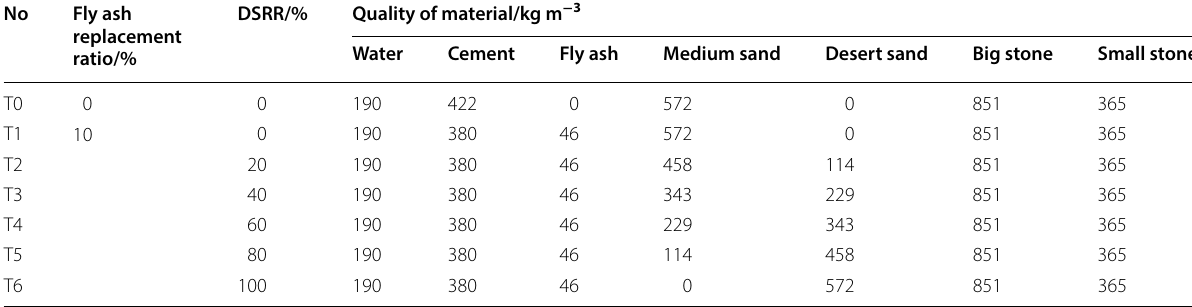
Table 1 Specific mix ratio of concrete produced with desert